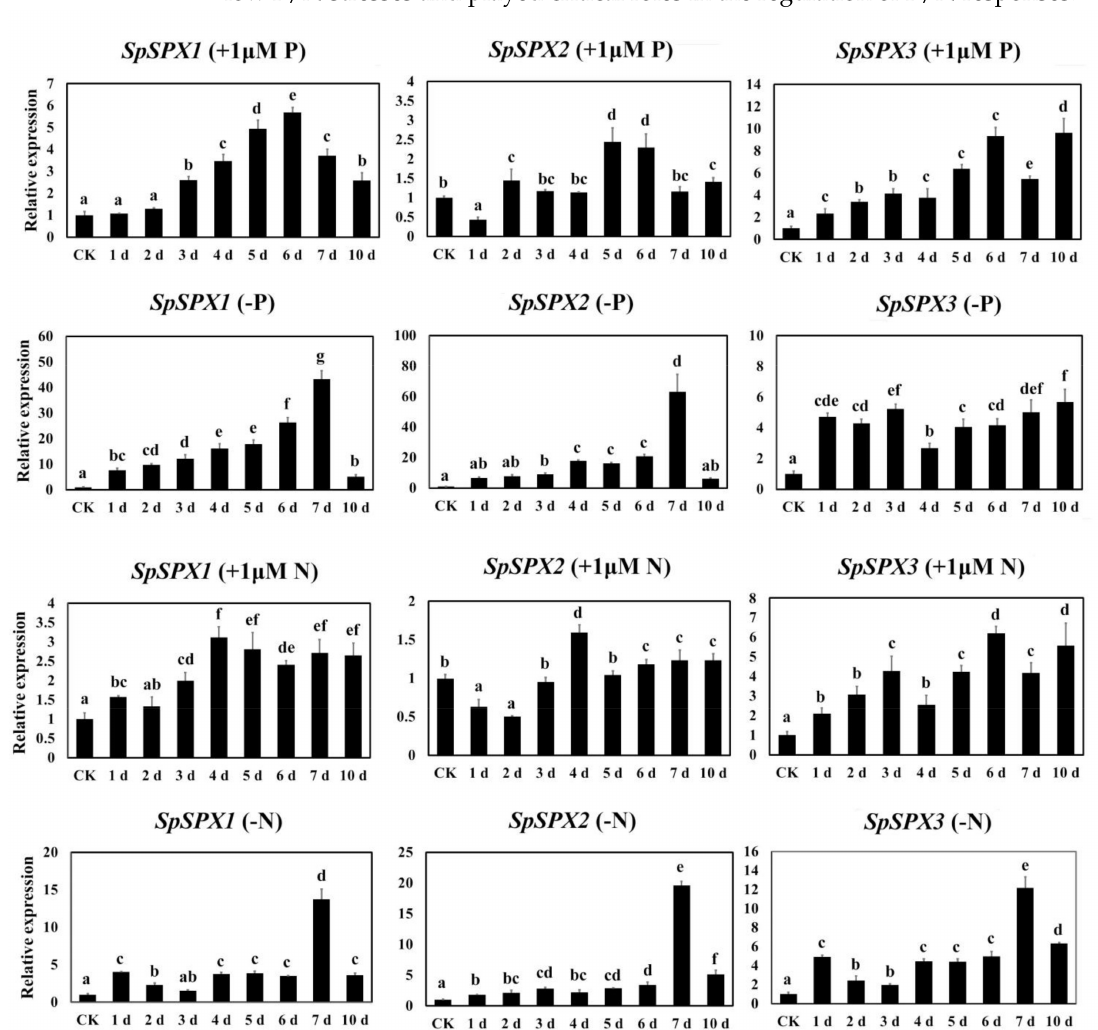
Figure 9. Quantitative RT-PCR analysis of three SpSPX genes under 1 µ M P/N and P/N deficiency conditions from 1 day to 10 day. Different letters indicate significant differences between treatments at the p < 0.05 level (Duncan test). Error bars indicate standard